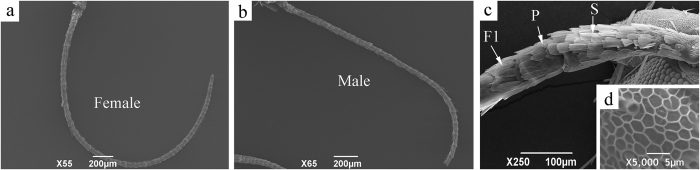
Overview of the general morphology of female and male antennae of Sitotroga cerealella.(a) Female antenna; (b) male antenna; (c) base of antenna, showing scape (S), pedicel (P) and the first segment of flagellum (F1); (d) the surface of the flagellar segments.